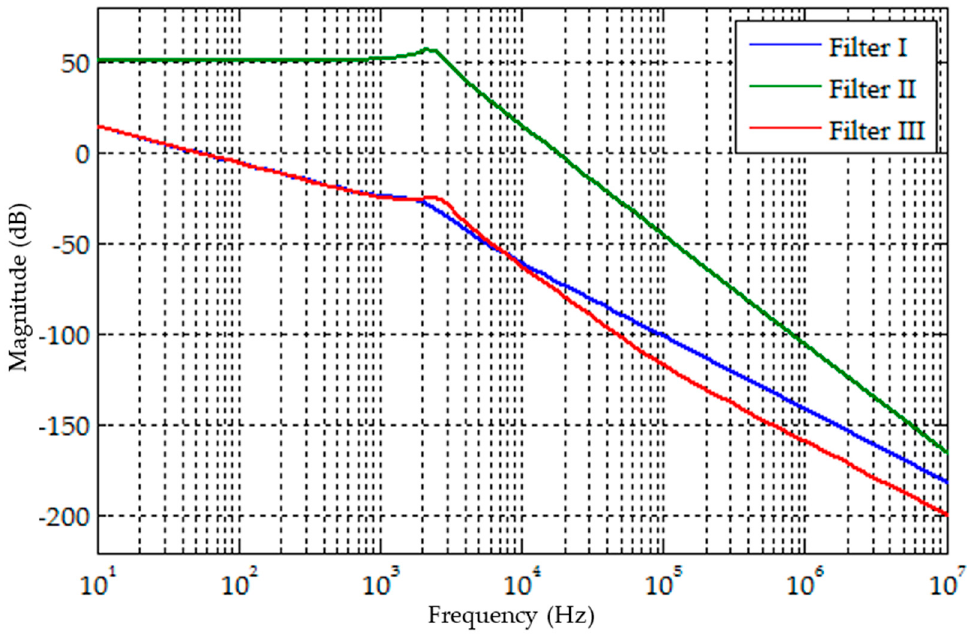
Figure 4. Frequency response characteristics with the three filters: Filter I, resistance damped LCL filter; Filter II, R d - C d damped LCL filter; and Filter III, proposed filter.